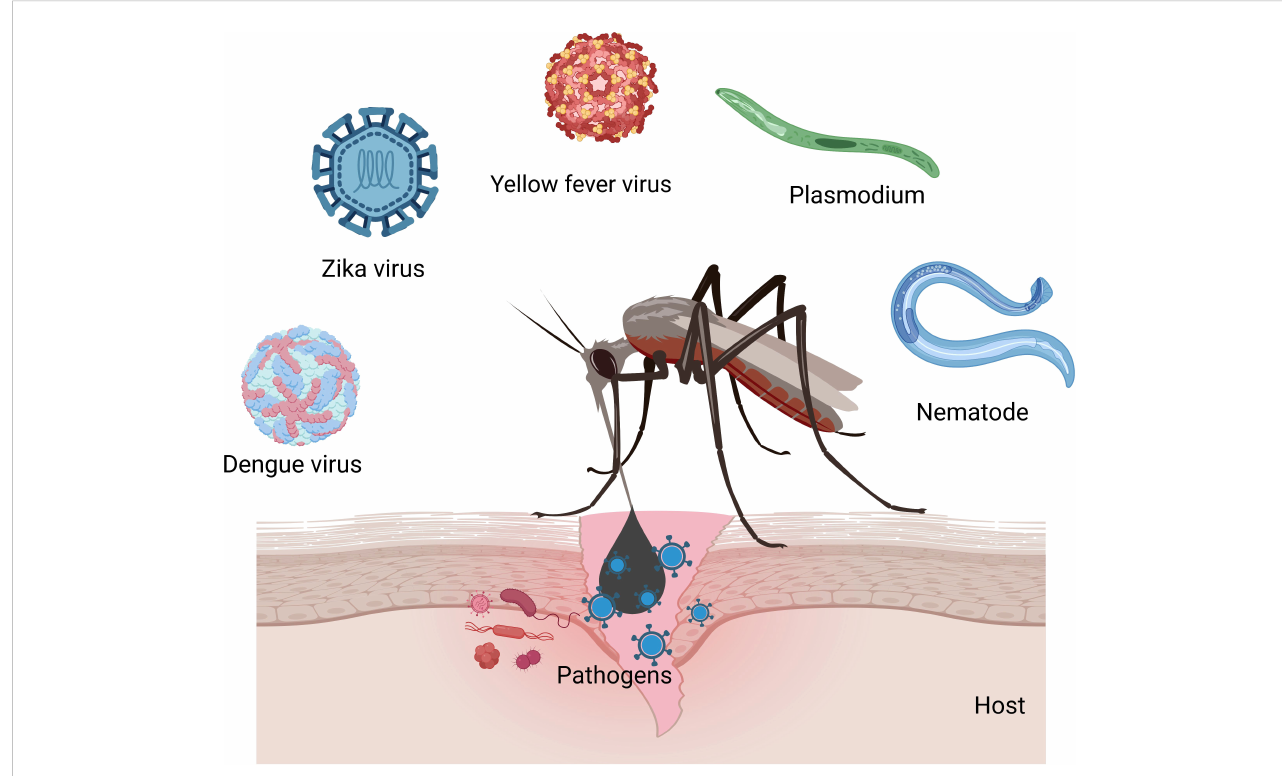
FIGURE 2 Mosquitoes transmit viruses (Zika, yellow fever, chikungunya, dengue, and West Nile), nematodes ( fi lariasis), and Plasmodium parasites (malaria) in